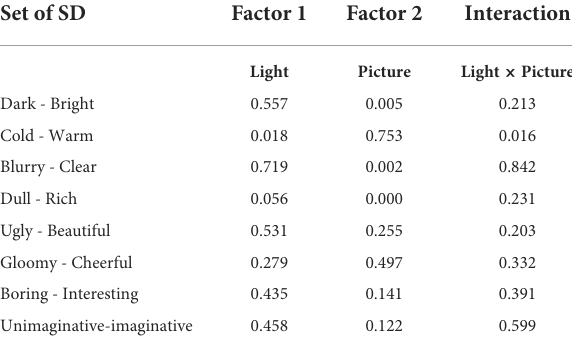
TABLE 7 Probability (P) value of